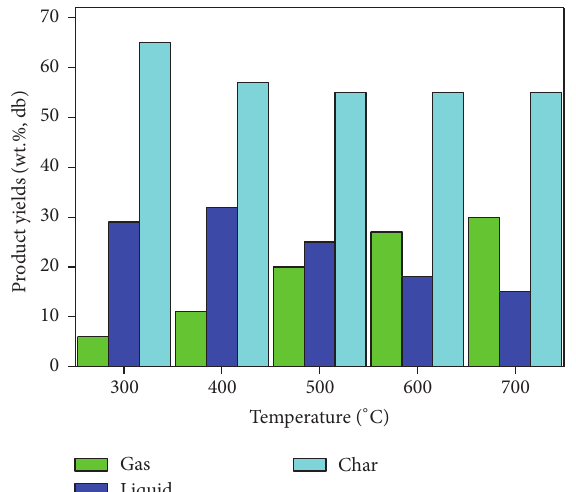
Figure 4: Pyrolysis product yields without and with catalyst.